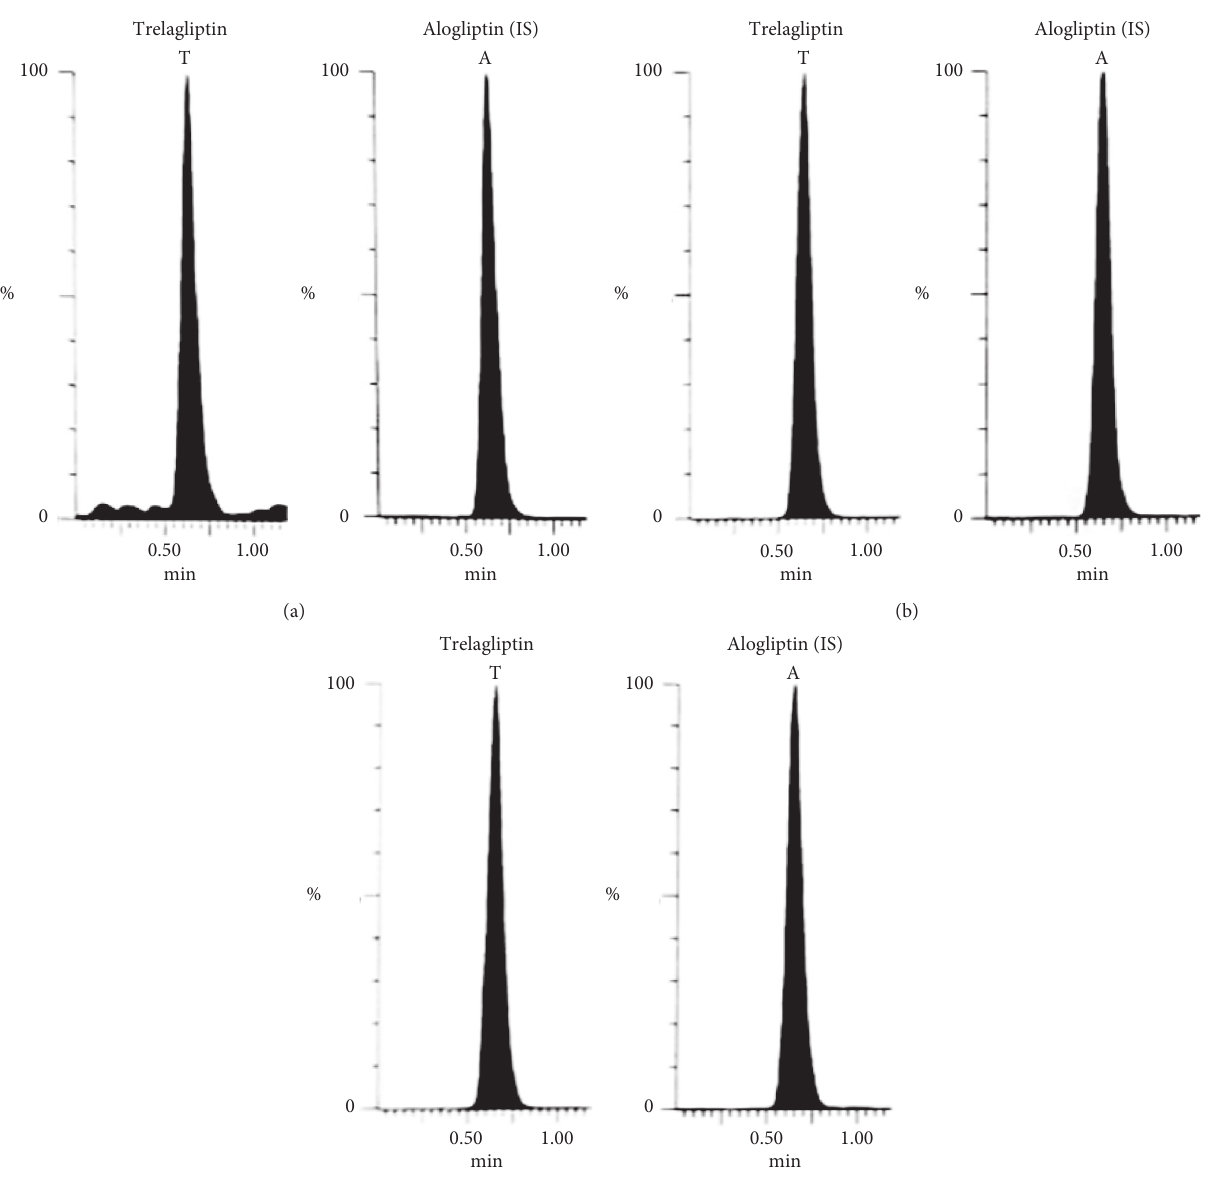
Figure 8: MRM of TLN (m/z � 358.2 to 133.9) and (IS, m/z � 340.2 to 116.0) in LQC, 12ng/mL (a), MQC, 500ng/mL (b), and 800ng/mL HQC (c) spiked human plasma validation